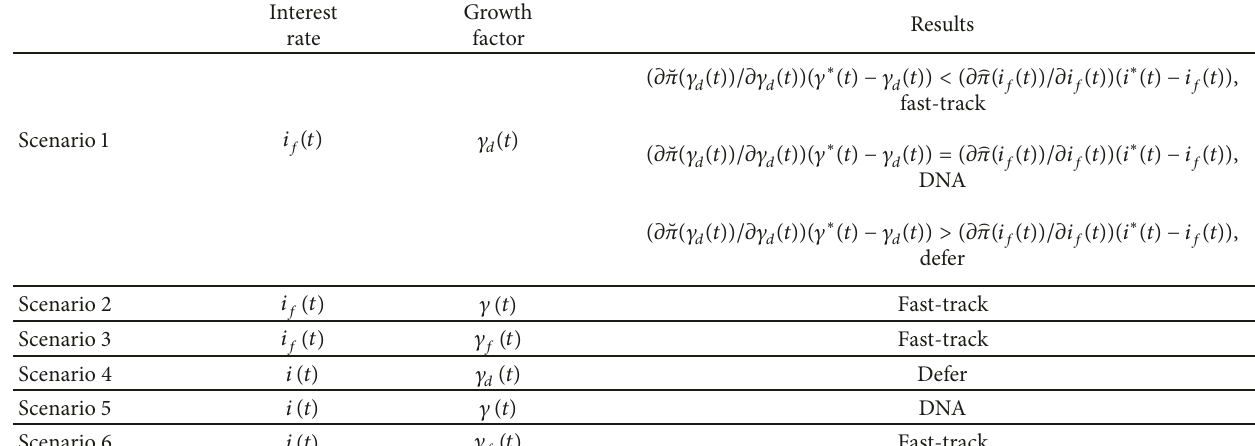
Table 3: Alternative choice with respect to different scenarios of growth factor of population density over years and interest rate ( 𝛾 𝑓 (𝑡) > 𝛾(𝑡) > 𝛾 (𝑡) and 𝑖 (𝑡) > 𝑖(𝑡) > 𝑖 (𝑡) 𝑑 𝑑 𝑓